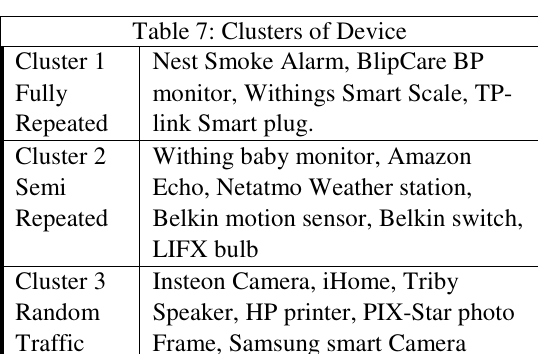
Table 7: Clusters of